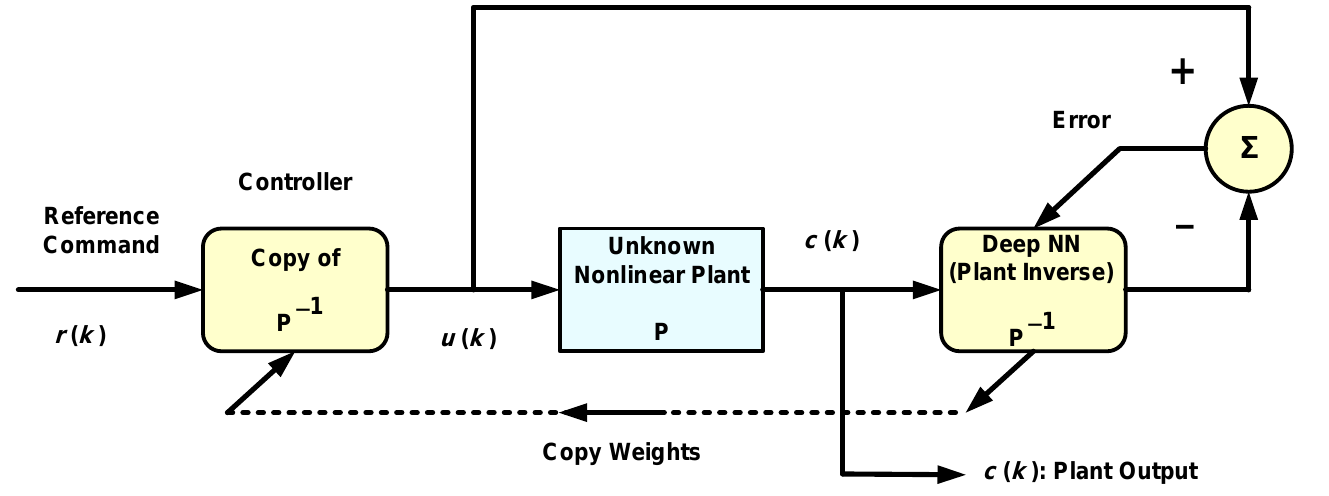
Figure 3. DL-based adaptive inverse control of a nonlinear plant.